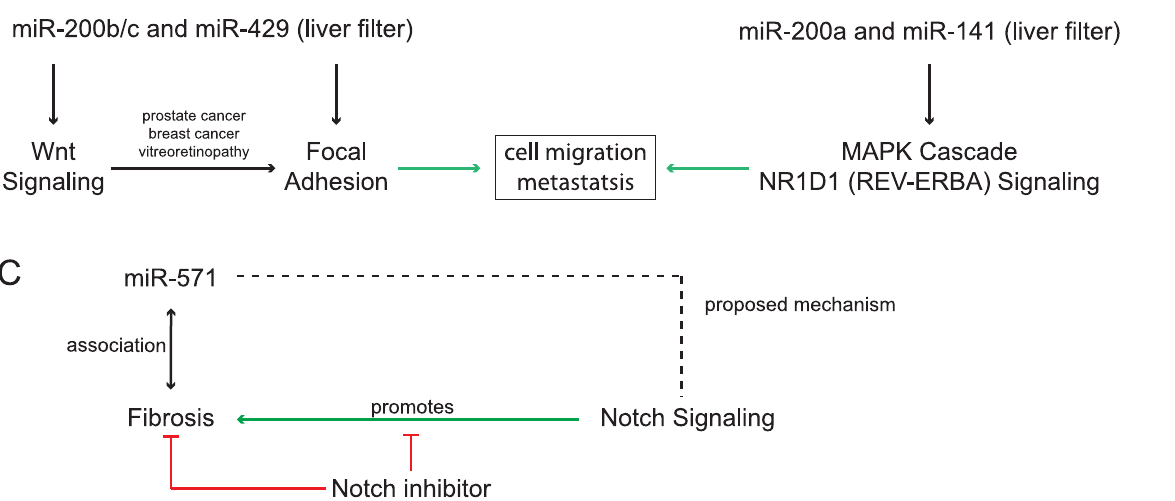
Fig 2. tissue specific enrichment of miRNAs in liver disease. (A) Targets of miR-199a/b-3p in the human KEGG Actin Cytoskeleton pathway (red). Only a section is shown, other parts are not targeted. Blue stars show genes also present in MAPK signaling. (B) Pathway analysis of miR-200 family using the liver filter. MiR-200b/c and miR-429 target Focal adhesion and Wnt signaling, pointing towards a regulatory interdependence in cancer formation. MiR-200a and miR-141 have different associated pathways but also target cancer related signaling. (C) MiR-571 is elevated in fibrosis and associated with notch signaling when using the liver filter. Notch inhibitors are in clinical studies for treatment of early stages of